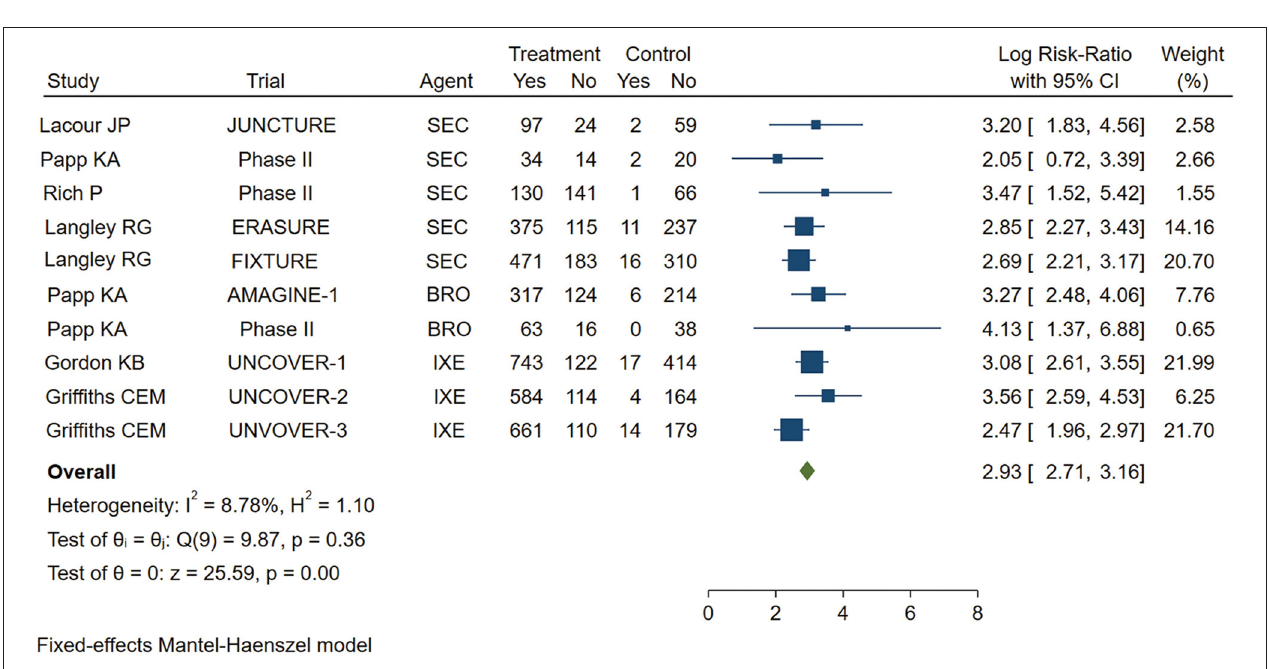
FIGURE 3 | Meta-analysis of Caucasian patients treated with IL-17 inhibitors or placebo for the PASI 75 response at week 12. RR, risk ratio; SEC, secukinumab; BRO, brodalumab; IXE, ixekinumab; Q4W, every 4 weeks; Q2W, every 2 weeks; IL-17, interleukin-17; PASI, Psoriasis Area and Severity Index 75.